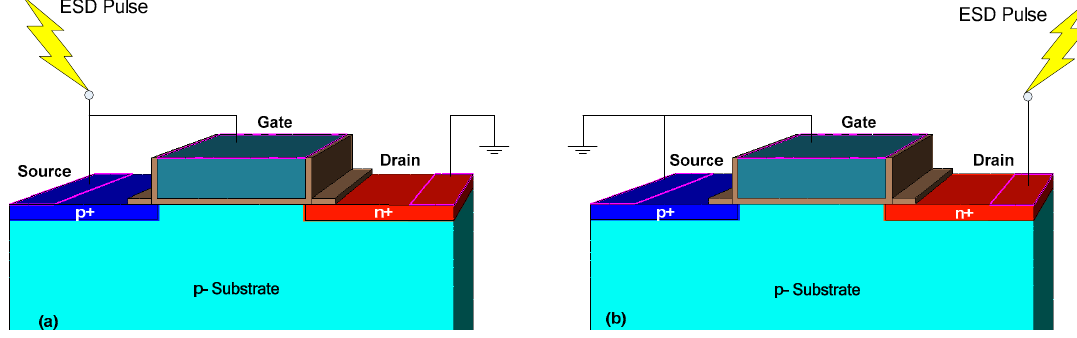
Figure 1. Schematics of tunnel field-effect transistor (TFET) under ( a ) negative and ( b ) positive electrostatic discharge (ESD) stresses.